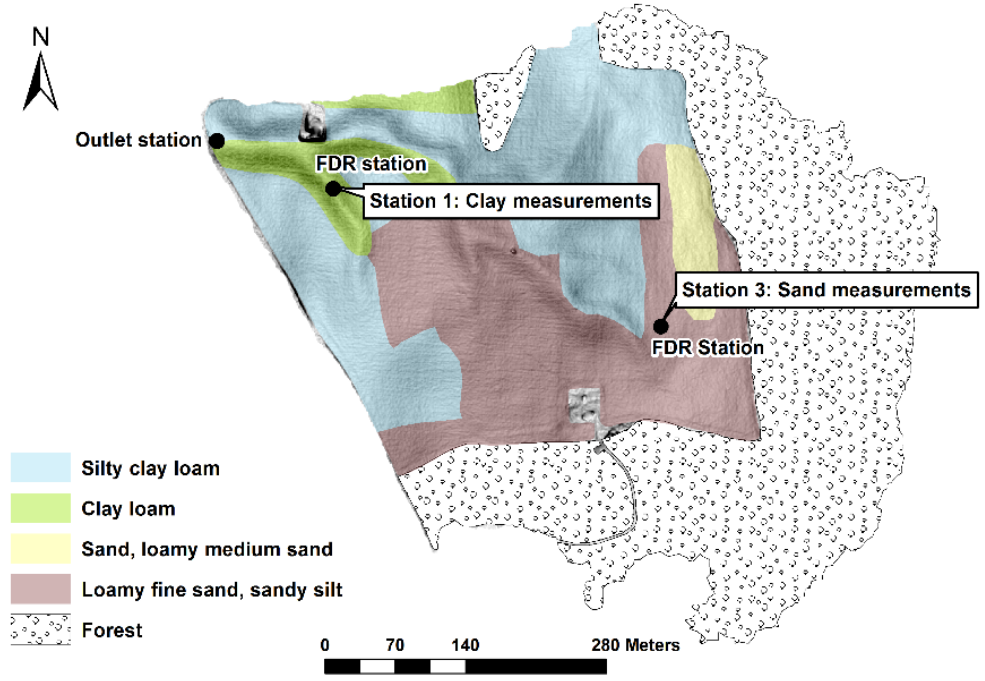
Figure 1. Soil and hill shade map of the Gryteland catchment in southern Norway. FDR, Frequency Domain Reflectometry.